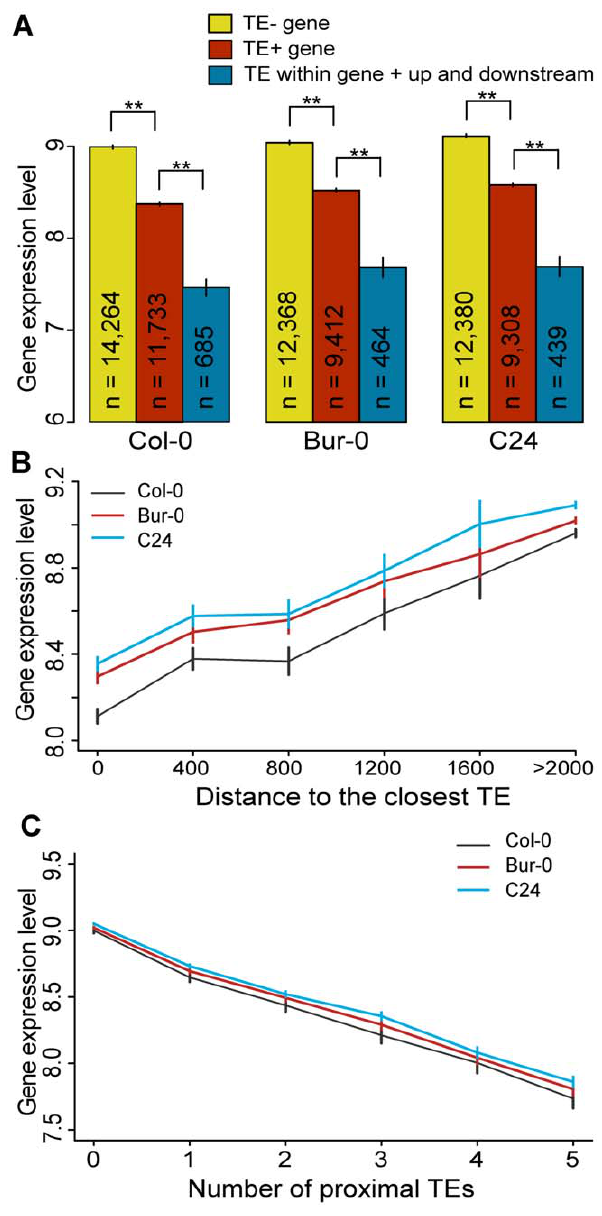
Figure 3. TEs and neighboring gene expression. (a) Average gene expression levels for TE 2 genes (yellow), TE + genes (red) and genes where TEs are located simultaneously within, upstream and down- stream of the genes (cyan). MWU [TE + /TE 2 ] p , 2 6 10 2 16 for Col-0, Bur-0 and C24, MWU [TE + /TE within gene + up and downstream] p # 2 6 10 2 14 for Col-0, Bur-0 and C24. (b) Average gene expression as a function of the distance to the nearest TE. Distance was binned into 400 bp windows. A distance of 0 indicates genes that contain a TE. Spearman’s r (Col-0)=0.15, r (Bur-0)=0.13, r (C24)=0.13; p , 2 6 10 2 16 ). (c) Average gene expression as a function of the number of proximal TEs. df=55, chi-square sums 915, 588 and 553 for Col-0, Bur-0 and C24, respectively, p , 2 6 10 2 16 . **=p , 0.01. Standard errors are